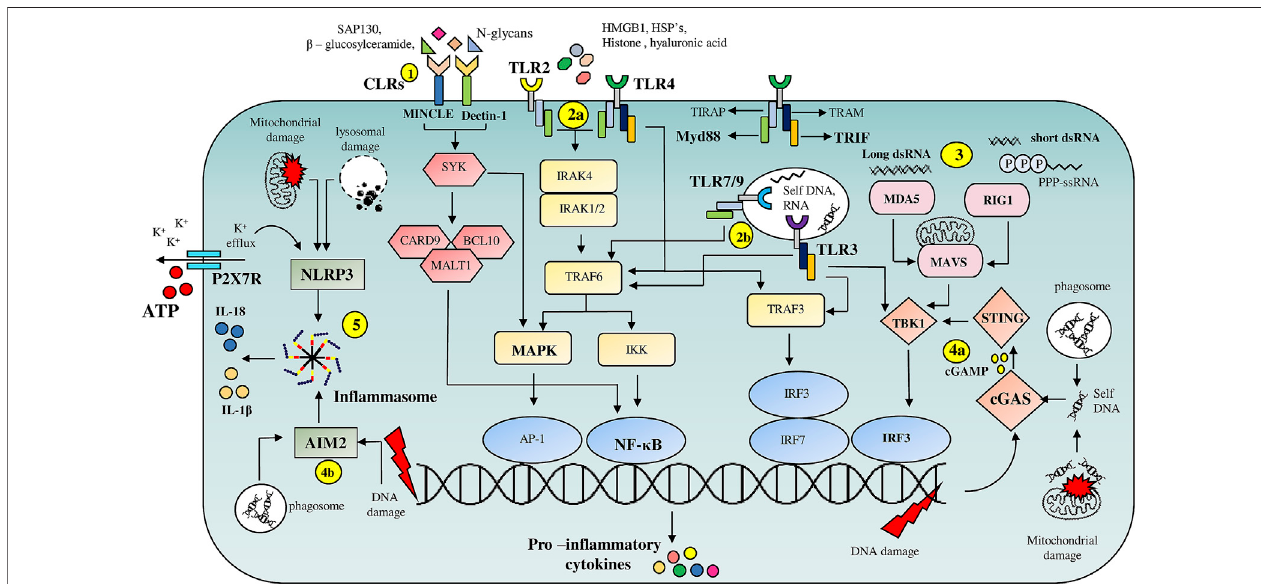
FIGURE1| OverviewofPRRmediatedDAMPsignalingpathways: (1) C-typelectinreceptors(CLR ’ s),MacrophageinducibleC-typelectin(MINCLE)andDectin-1, on bindingtoDAMP ’ ssuch asSin3Aassociatedprotein 130(SAP-130), β — glucosylceramideand N-glycans respectively, triggerNF- κ BandMAPKsignaling pathways via engagingspleentyrosinekinase(SYK). (2) CellsurfacelocalizedTLR ’ s (2a) ,TLR2andTLR4,areactivatedbyintracellularproteinssuchasHMGB1,HSP ’ s,histones, whereas endosomal TLR ’ s (2b) , TLR7, TLR9 and TLR3 are activated by nucleic acids. TLR ’ s activate multiple pro-in fl ammatory signaling pathways through their adaptor proteins MyD88 and TRIF. (3) Host derived RNA molecules are recognized by RLR ’ s such as RIG-1 and MDA5 which then via mitochondrial antiviral signaling system (MAVS) adaptor protein activate TBK-1 resulting in IRF3 dependent transcription of pro-in fl ammatory cytokine genes. (4) cGAS and AIM2 serve as cytoplasmic nucleicacid sensors. cGAS (4a) binds toDNA fragments derived from either genomic damage or from debris phagocytosed after tissue damage resulting in the release of cyclin GMP — AMP (cGAMP) second messenger which on binding to stimulator of interferon genes (STING) drives IRF3 dependent transcription of in fl ammatory cytokinegenes. (4b) AIM-2 onbindingtonucleicacidfragmentsresultsintheassemblyofin fl ammasomefacilitatingreleaseofpro-in fl ammatory cytokinessuchasIL-1 β and IL-18. (5) NLRP3 based in fl ammasomeassembly istriggered bynumerous eventssuch asATP-P2X7Rmediated K + ef fl ux and mitochondrial or lysosomaldamage resulting in the release of IL-1 β and